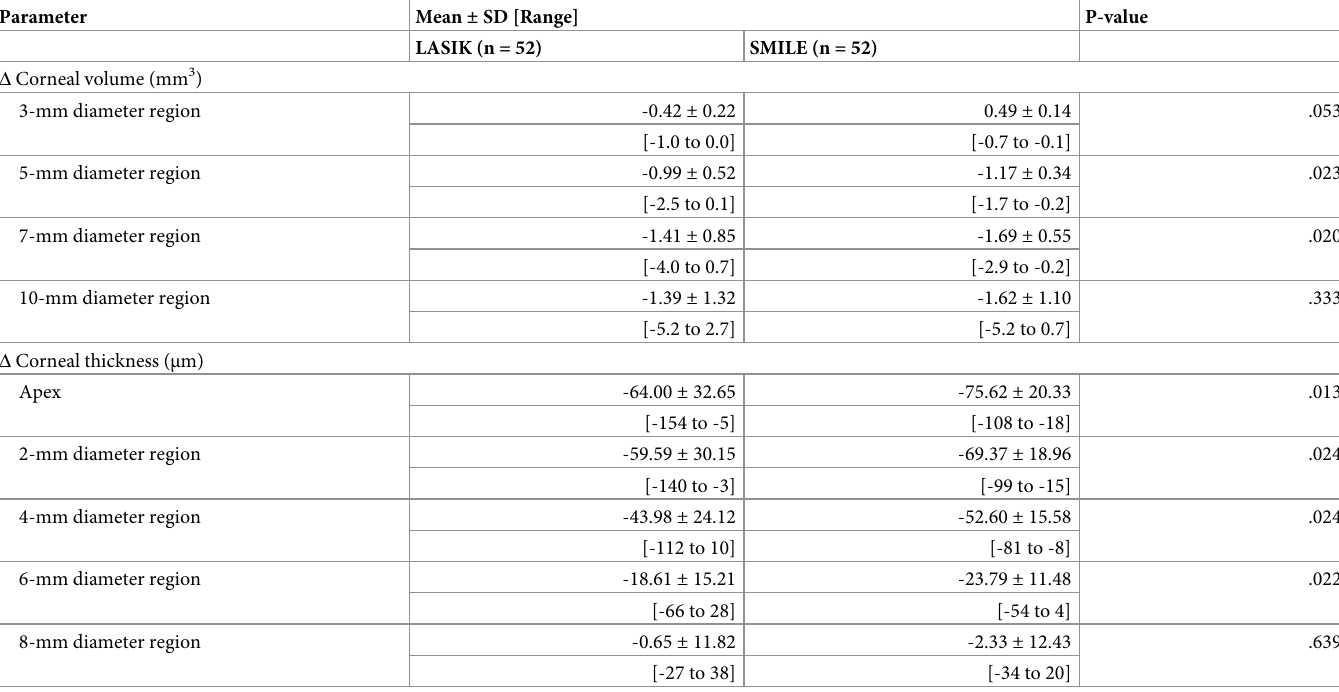
Table 3. Differences of 12-month postoperative minus preoperative